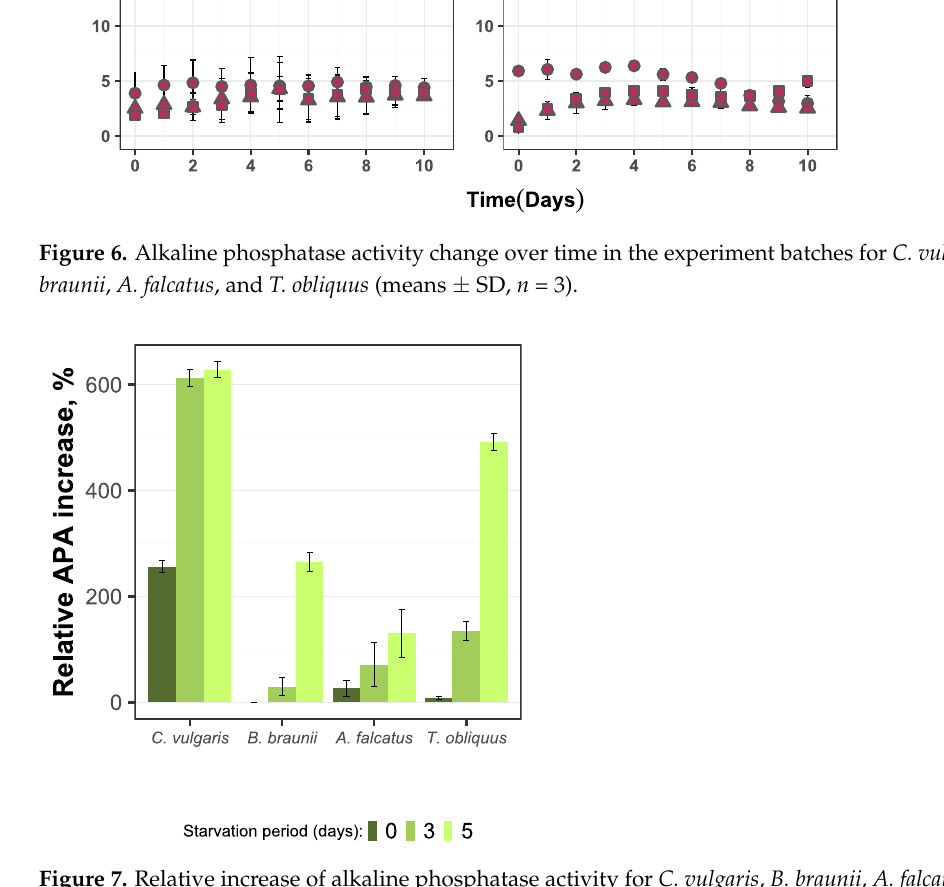
Figure 7. Relative increase of alkaline phosphatase activity for C. vulgaris, B. braunii, A. falcatus, and T. obliquus (means ± SD, n = T. obliquus (means ± SD, n = 3).